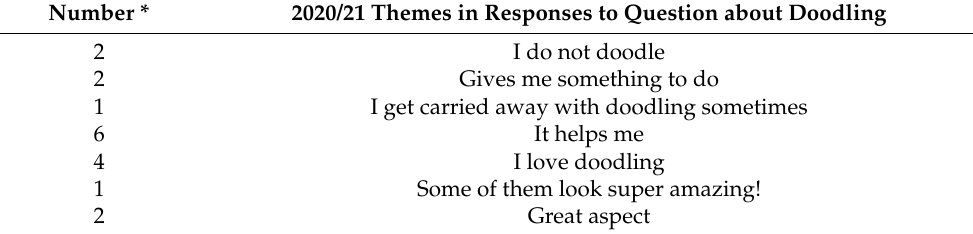
Table 11. Themes in Responses Provided on the April Feedback Forms of the Academic Year in Answer to What Are Your Thoughts on the Doodling Aspect of the HeNReG Experience? For the Academic Year When the Question Was Included on the Feedback Form in Order of Receipt from